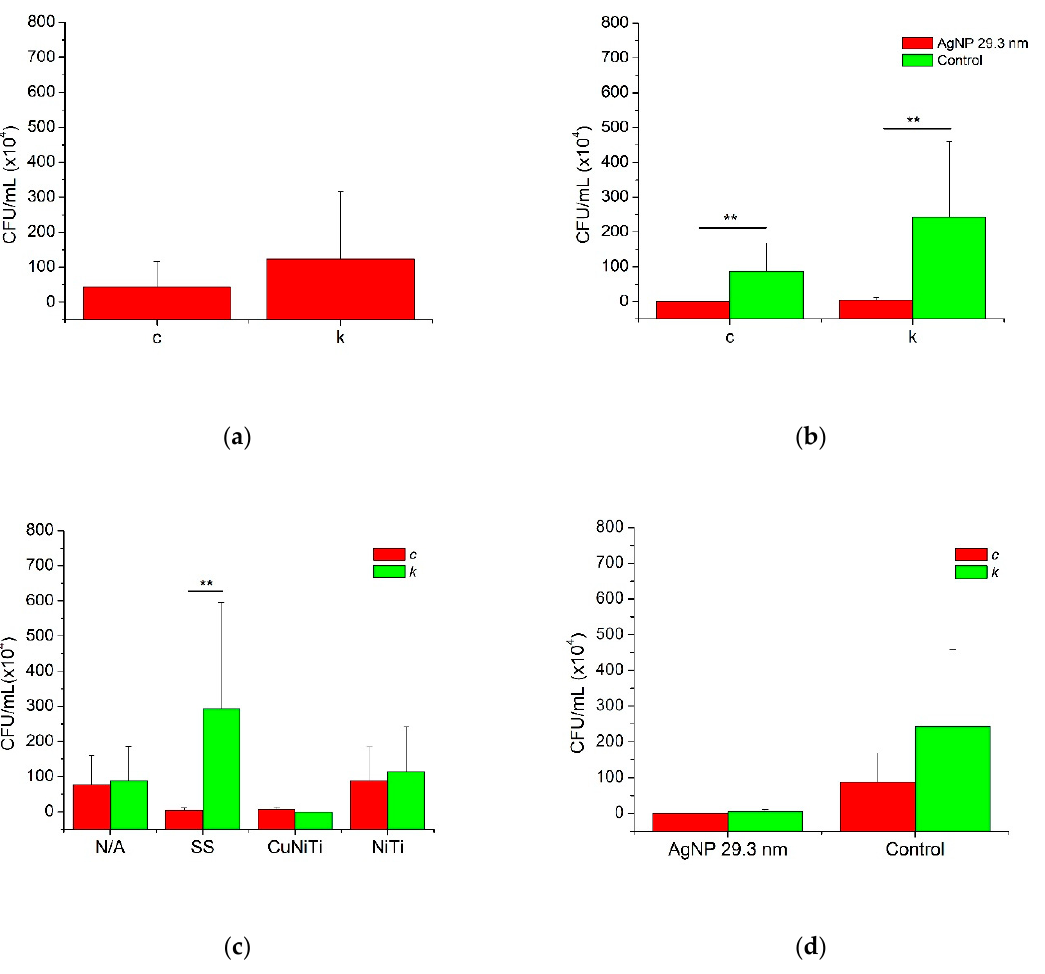
Figure 3. The anti-adherence activity of AgNP according to S. mutans serotypes. AgNP = silver nanoparticles; N/A = no archwire; SS = stainless steel; CuNiTi = copper/nickel/titanium; and NiTi = nickel/titanium. Statistical comparisons between groups (AgNP and distilled water) and subgroups (orthodontic wires and S. mutans serotypes) were analyzed by Mann–Whitney U test for non-parametric values. Statistical differences were presented using asterisks ( ** = p < 0.01).